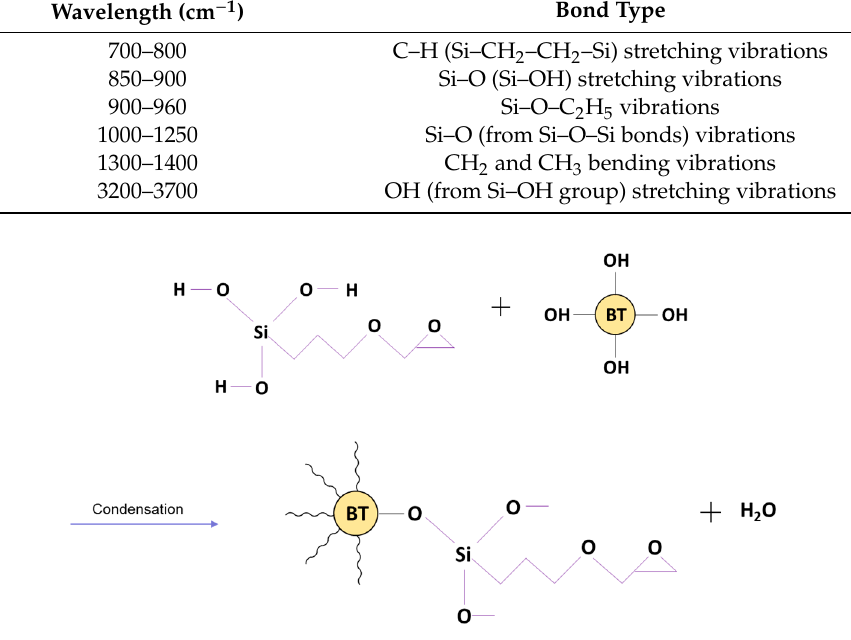
Figure 26. A condensation reaction occurs between the newly formed Si–OH groups of the coupling agent and the hydroxyl groups adsorbed on the surface of the BaTiO 3 nanoparticle. Table 5. Wavelength (cm − 1 ) and bond type found in silane films.